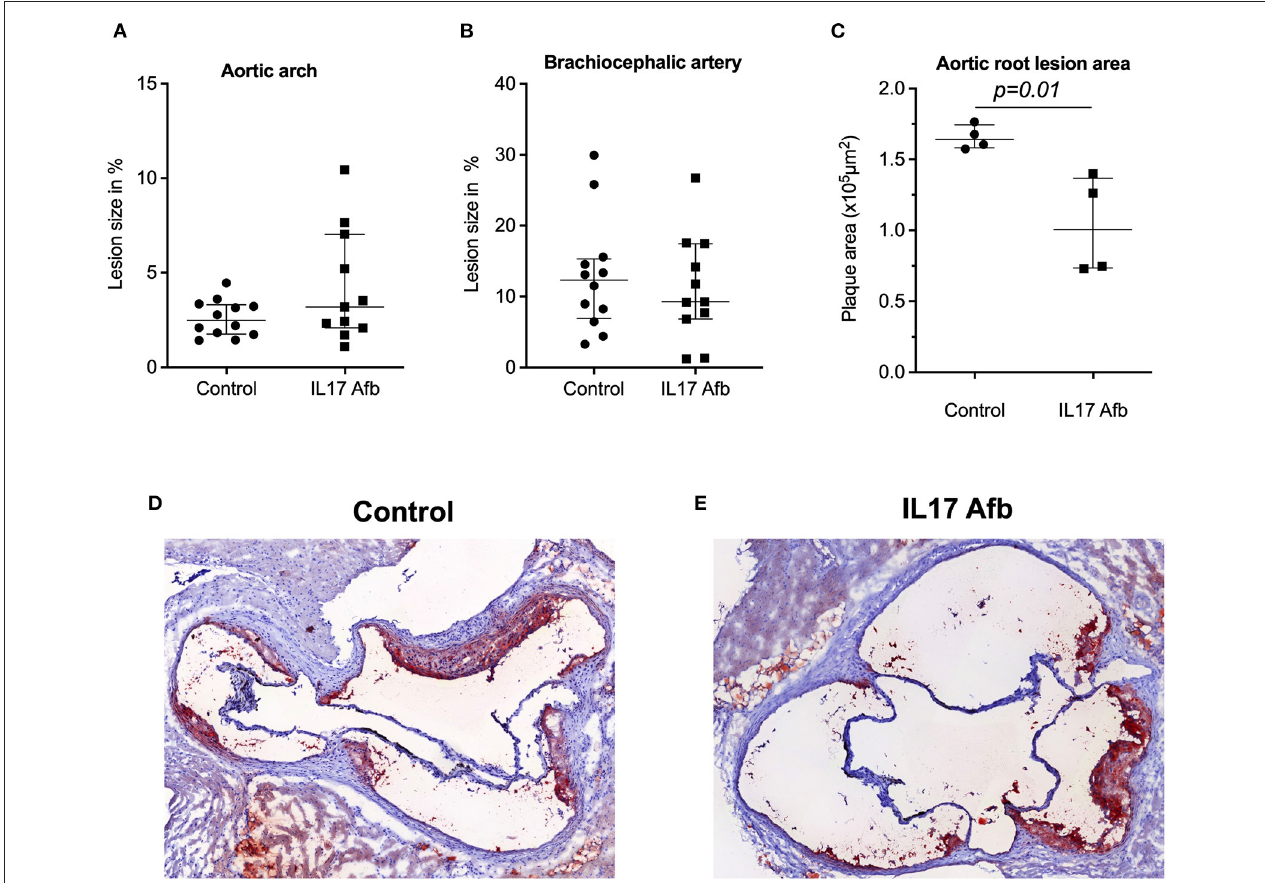
FIGURE 2 | Effect of Affibody molecule targeting IL17A in atherosclerotic lesion development in ApoE − / − mice. Quantification of lesion size (%) in the aortic arch (A) and brachiocephalic artery (B) of control mice and α IL17A Affibody molecule treated mice. Quatification of lesion areas ( µ m 2 ) in the aortic root (C) . Representative Oil Red O immunostainings from the aortic root of control (D) and mice treated with α IL17A Affibody molecule (E) . Data are presented as Median with